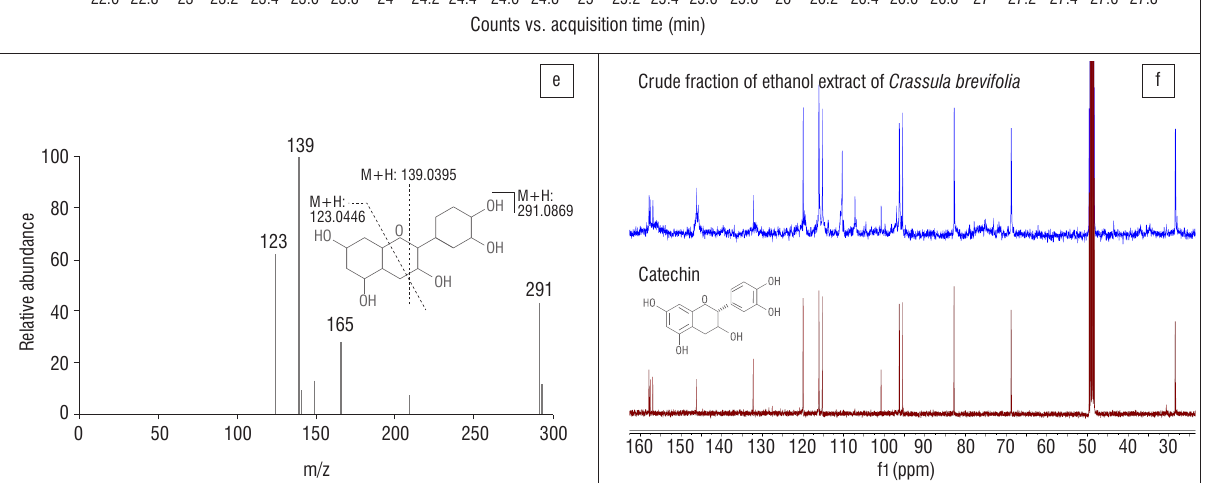
Figure 2: Ways of seeing Crassula brevifolia : (a) whole plant, (b) leaves, (c) comparison of proton magnetic resonance spectra of ethanol extract of C. brevifolia with similar extracts from other plants, (d) section (22–28 min) of the total ion chromatogram from liquid chromatography–mass spectrometry analysis of the ethanol extract of C. brevifolia , (e) tandem mass spectrum of catechin, showing masses of prominent ions, with the structure and fragmentation pattern of the molecule overlaid and (f) carbon magnetic resonance spectrum of pure catechin, and the mixture from which it was